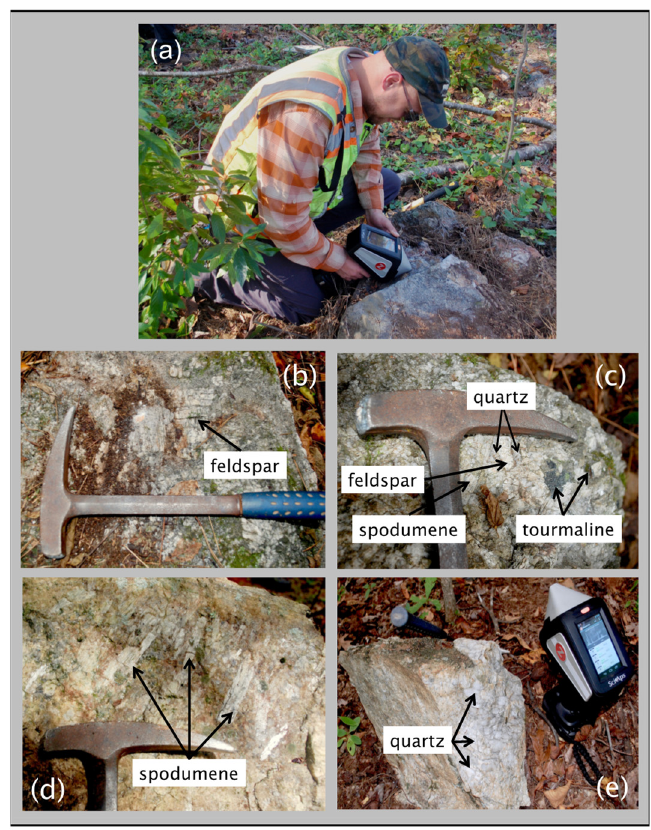
Figure 4. In-field LIBS analysis of pegmatite outcrops on the Carolina Lithium Project prospect in Gaston County, N.C., showing the use of the handheld LIBS analyzer for in-situ analysis ( a ) and examples of the different minerals analyzed — feldspar ( b ); feldspar, quartz, spodumene, and tourmaline ( c ); spodumene ( d ); and quartz (e).